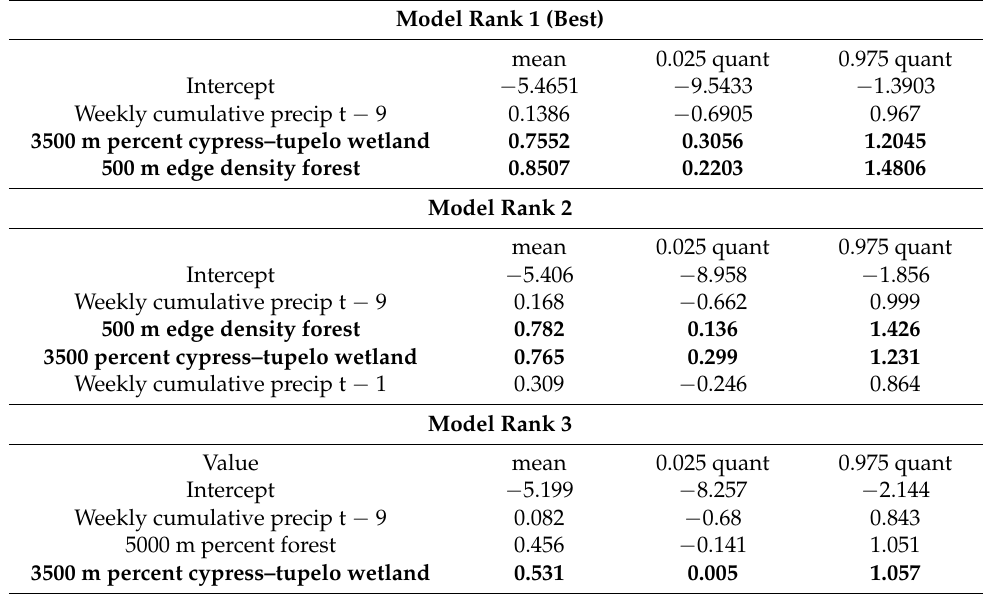
Table 3. The credible intervals for the EEEV 95% confidence set (Model Ranks 1–3). The variables in bold indicate that the data support a strong effect on EEEV seroconversion. The sign of the mean indicates a positive or negative effect. If values cross zero between the 0.025 quant and the 0.975 quant, the variable is not important for